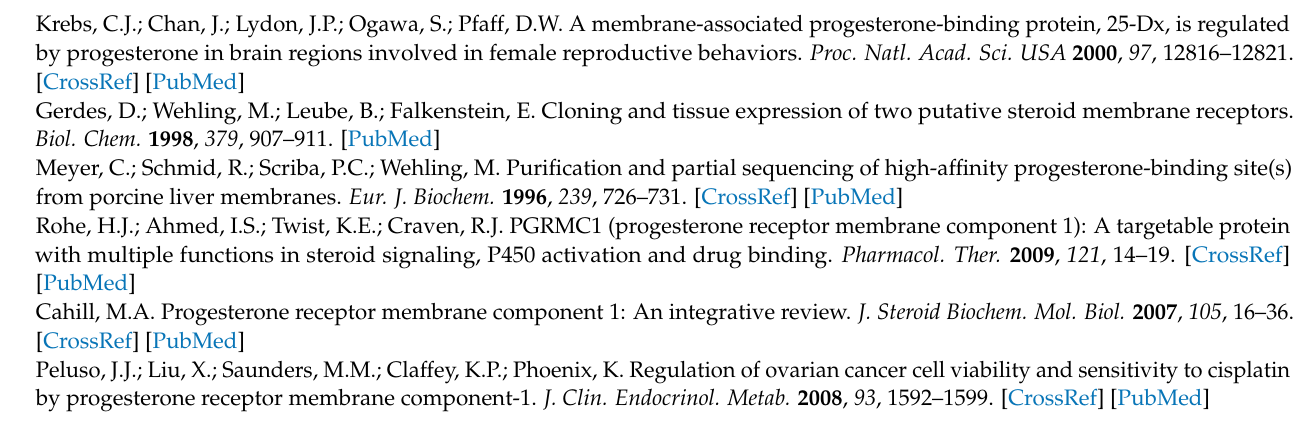
Figure S3: HDX analysis of GL-PGRMC1 binding, Figure S4: Raw data of ITC analyses of the binding between GL derivatives and heme-dimerized PGRMC1, Figure S5: ITC analysis of the binding of high-mobility group box 1 (HMGB1) to GL, and PGRMC1 to AG205, Figure S6: The effect of the heme-dimerization of PGRMC1 by SA, Figure S7: The effect of GL derivatives to the EGF signaling in HuH7 cells, Figure S8: Time-course analyses of the effect of GlucoGL to EGF signaling in HCT116 cells, Figure S9: The in vitro effect of EGFR kinase on GL derivatives, Figure S10: GL derivatives inhibit the interaction between PGRMC1 and cytochrome P450 3A4 (CYP3A4) in vitro, Figures S11 and S12: The effect of GL derivatives on erlotinib/CDDP sensitivity in HCT116 cells, Figure S13: The effect of GL derivatives on erlotinib/CDDP sensitivity in HCT116 cells Figure S14: Full images of western blots, Table S1: Binding affinities of PGRMC1 mutants for GL based on ITC